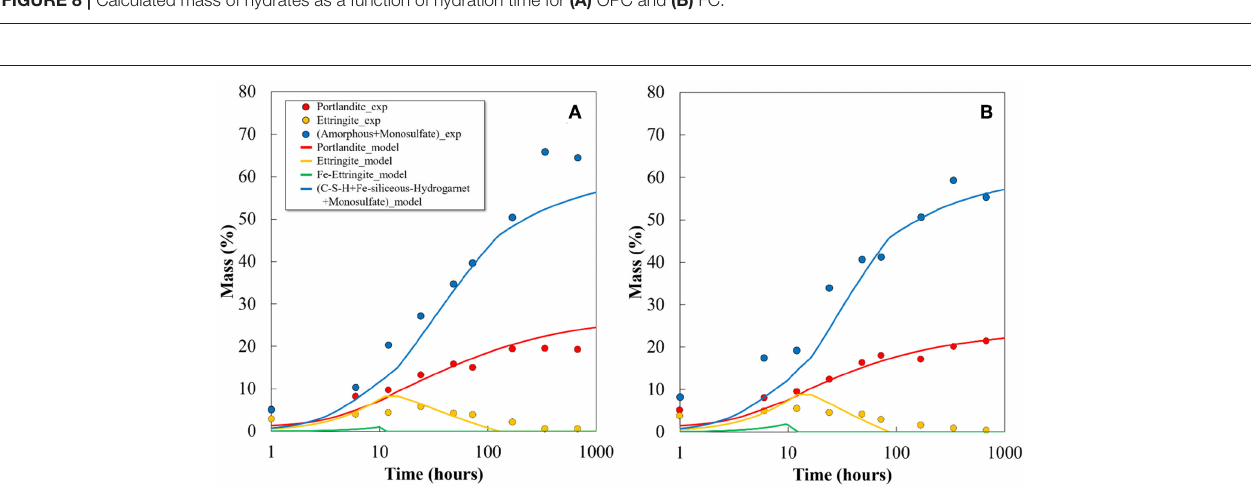
FIGURE 9 | Comparison of calculated hydrates with quantitative value determined by XRD Rietveld analysis and TG/DTA for (A) OPC and (B) FC.